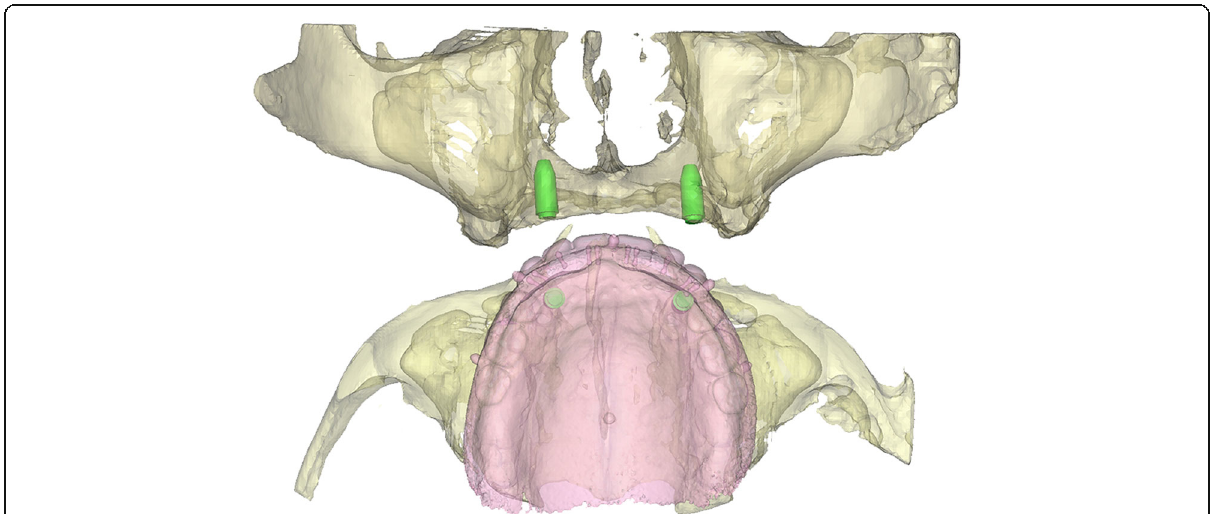
Fig. 1 Implant planning. The images of the patient and the prosthesis are segmented, aided by the double scan method, and the implants are virtually planned in a prosthetically driven way